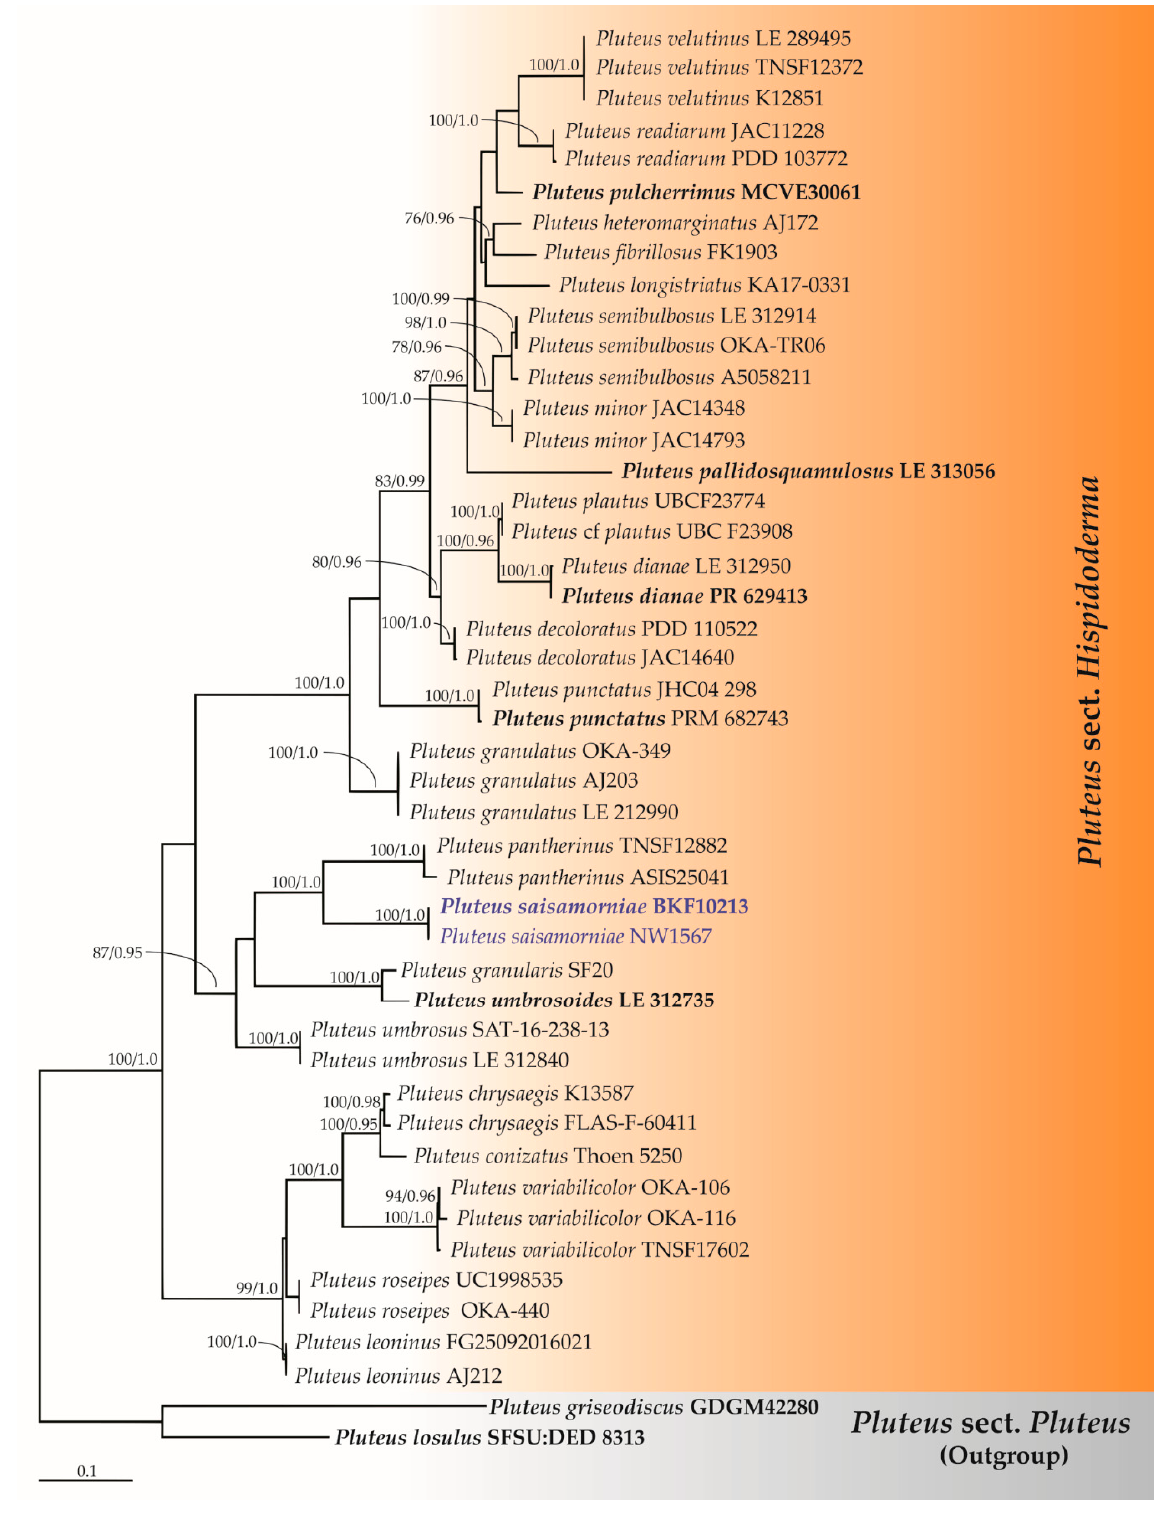
Figure 2. Phylogram derived from maximum likelihood analysis of Pluteus sect. Hispidoderma consists of 46 taxa of ITS sequences. Pluteus griseodiscus and P. losulus were used as the outgroup. The numbers above branches represent bootstrap percentages ( left ) and Bayesian posterior probabilities ( right ). Bootstrap values ≥ 75% and Bayesian posterior probabilities ≥ 0.90 are shown. The scale bar represents the expected number of nucleotide substitutions per site. Sequences obtained from this study are in blue. Type specimens are in bold.